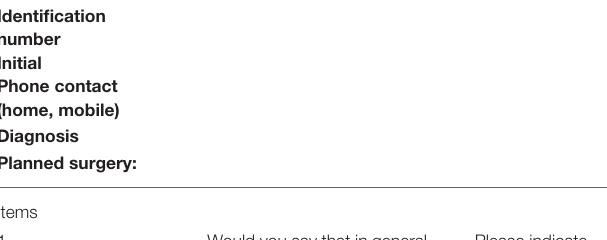
TABLE 1 | Item of the telephone interview: general